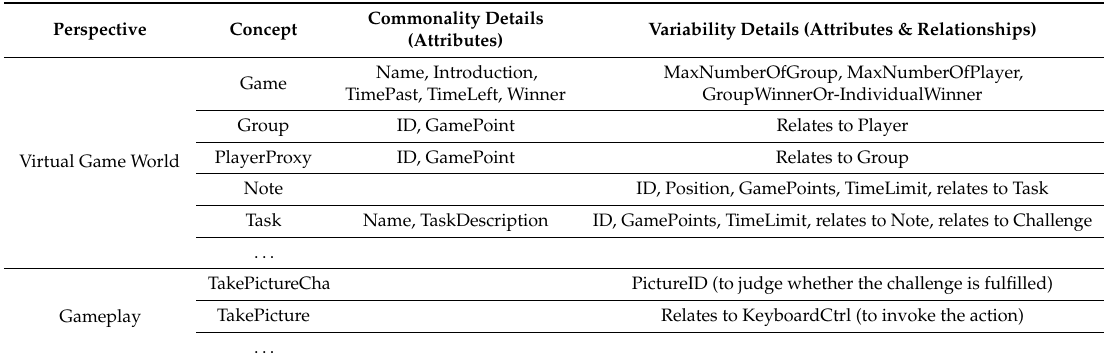
Table 2. The domain analysis table for the PervasiveTreasureHunting